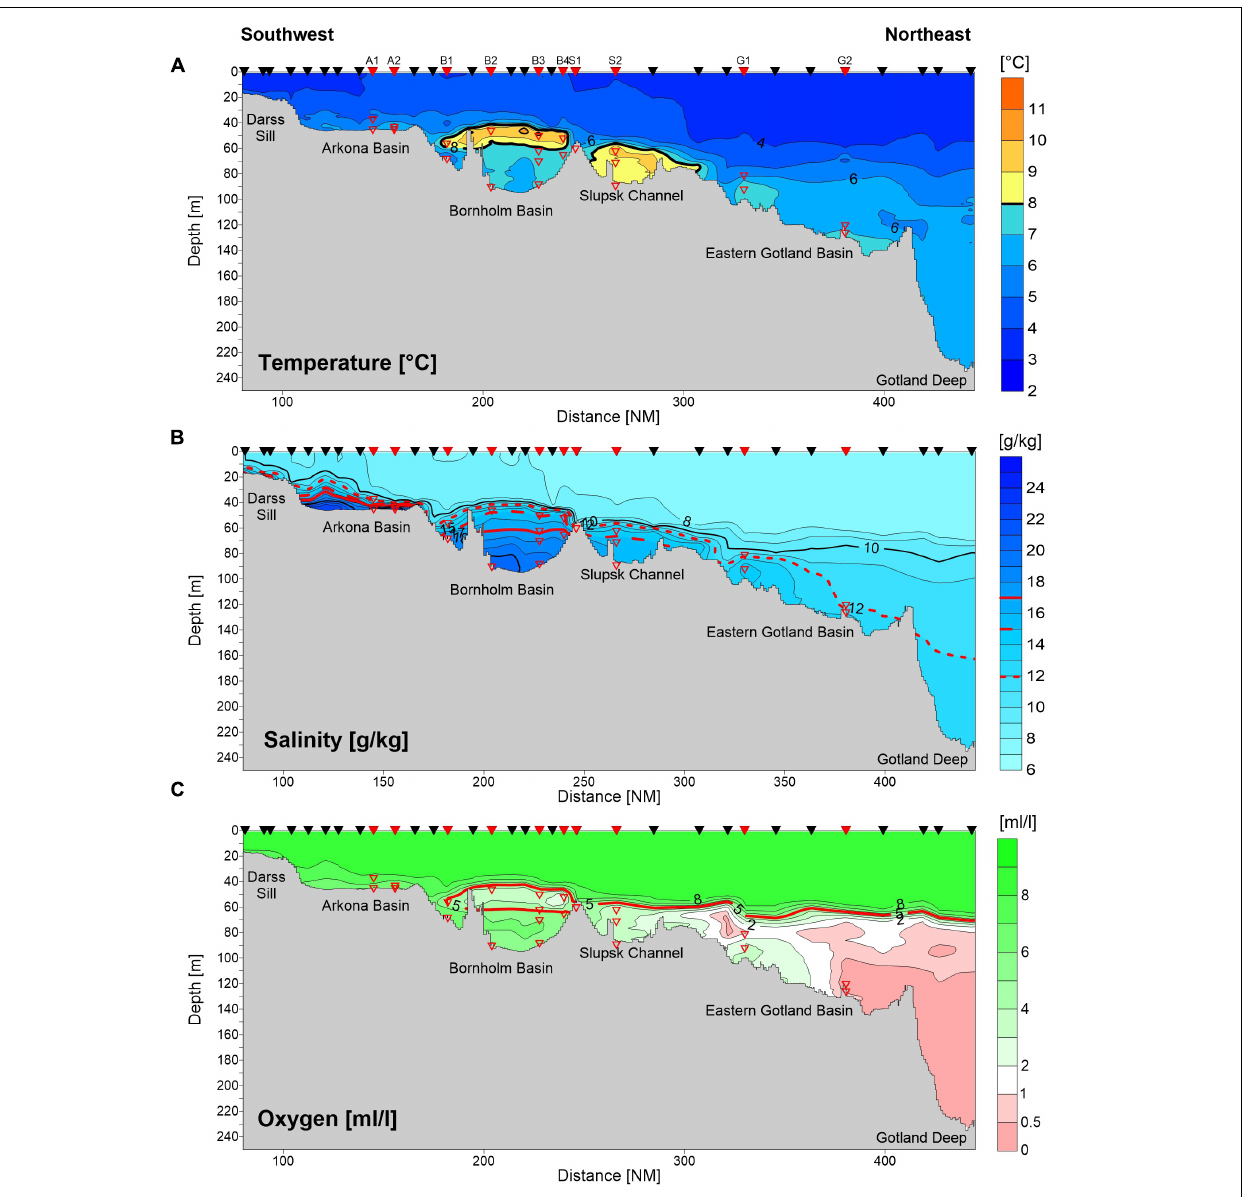
FIGURE 3 | Bathymetric map of the southwestern Baltic Sea, showing the sampling locations and inflow pathways and a vertical cross-section, also showing the sampling locations (top of graphs; black triangles: only CTD measurements; red triangles: CTD and microbiological measurements) together with temperature (A) , salinity (B) , and oxygen concentrations (C)